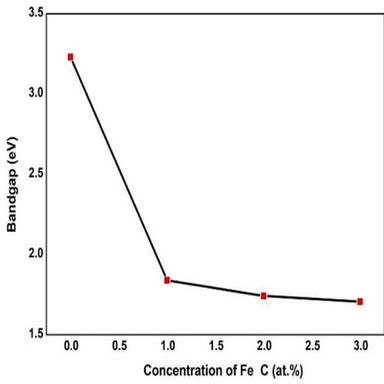
Variation of bandgap of the material with concentration of doping.